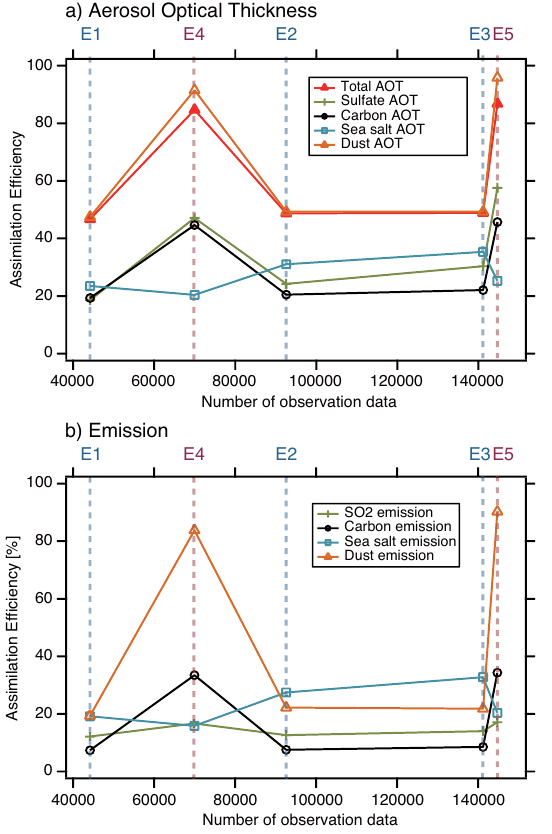
Fig. 10. The relationships between AE and the number of assimi- lated observations for (a) aerosol optical thickness and (b) aerosol